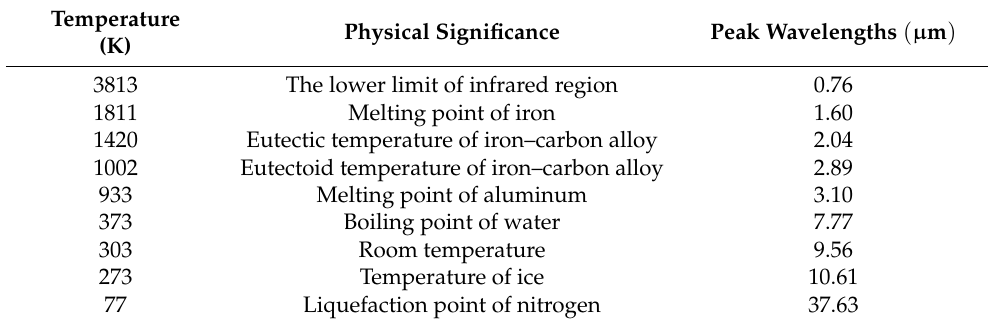
Table 1. The peak wavelengths of the emission spectra of typical physical events at different abso- lute